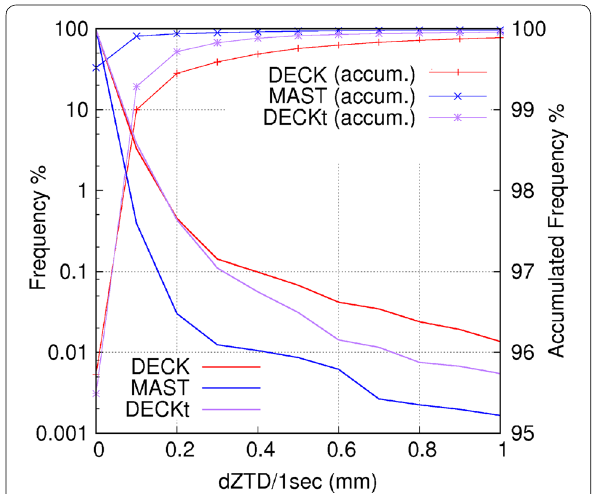
Fig. 4 Frequency distribution of the 1 s ZTD variation obtained from the shipborne GNSS observations. The lines indicate the frequency of each bin divided by a 0.1-mm interval (left axis). The lines with points indicate the accumulated frequency (right